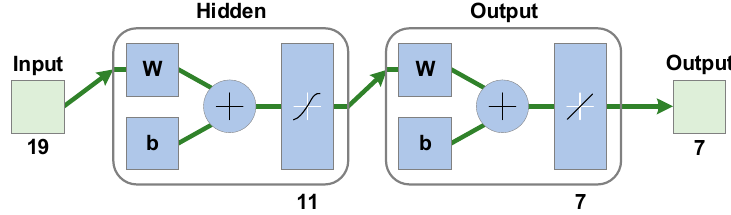
Figure 7. BP neural network interlayer coefficient setting.